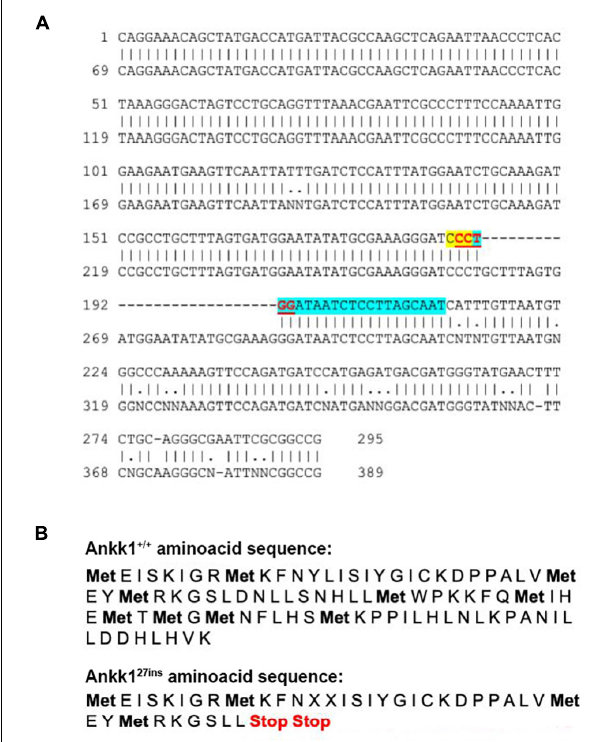
FIGURE 1 | CRISPR-Cas9 generated a 27 bp insertion that disrupts the ankk1 sequence (A) Comparison of wild type (top) and mutant (bottom) ankk1 sequences. crRNA is highlighted in blue. PAM sequence is highlighted in yellow. The restriction site (that is disrupted in the F 0 screening) appears in red, underlined. (B) Comparison of wild type (top) and mutant (bottom) amino acid sequences. Mutant sequence generates an early stop codon.